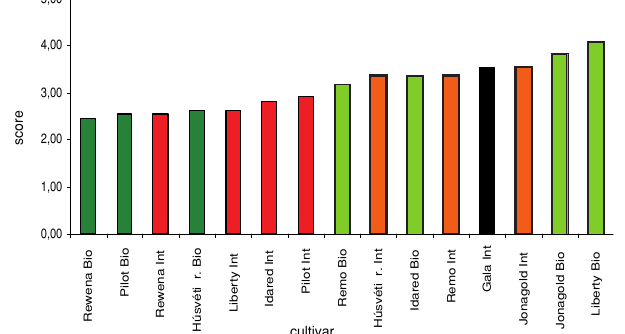
Figure1. Evaluation of apple samples according to their acid-sugar harmony (Debrecen,